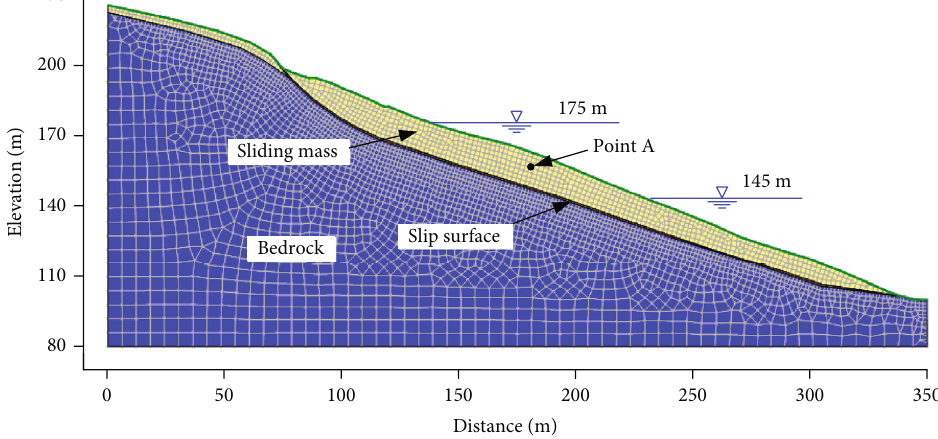
Figure 5: Numerical seepage analysis model of the Woshaxi